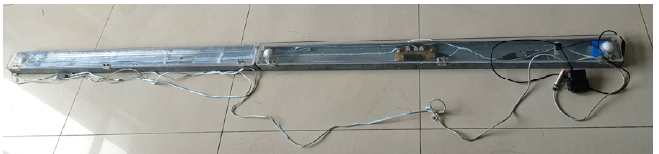
Figure 12. Hardware equipment of vehicle-mounted tunnel illumination detection device.